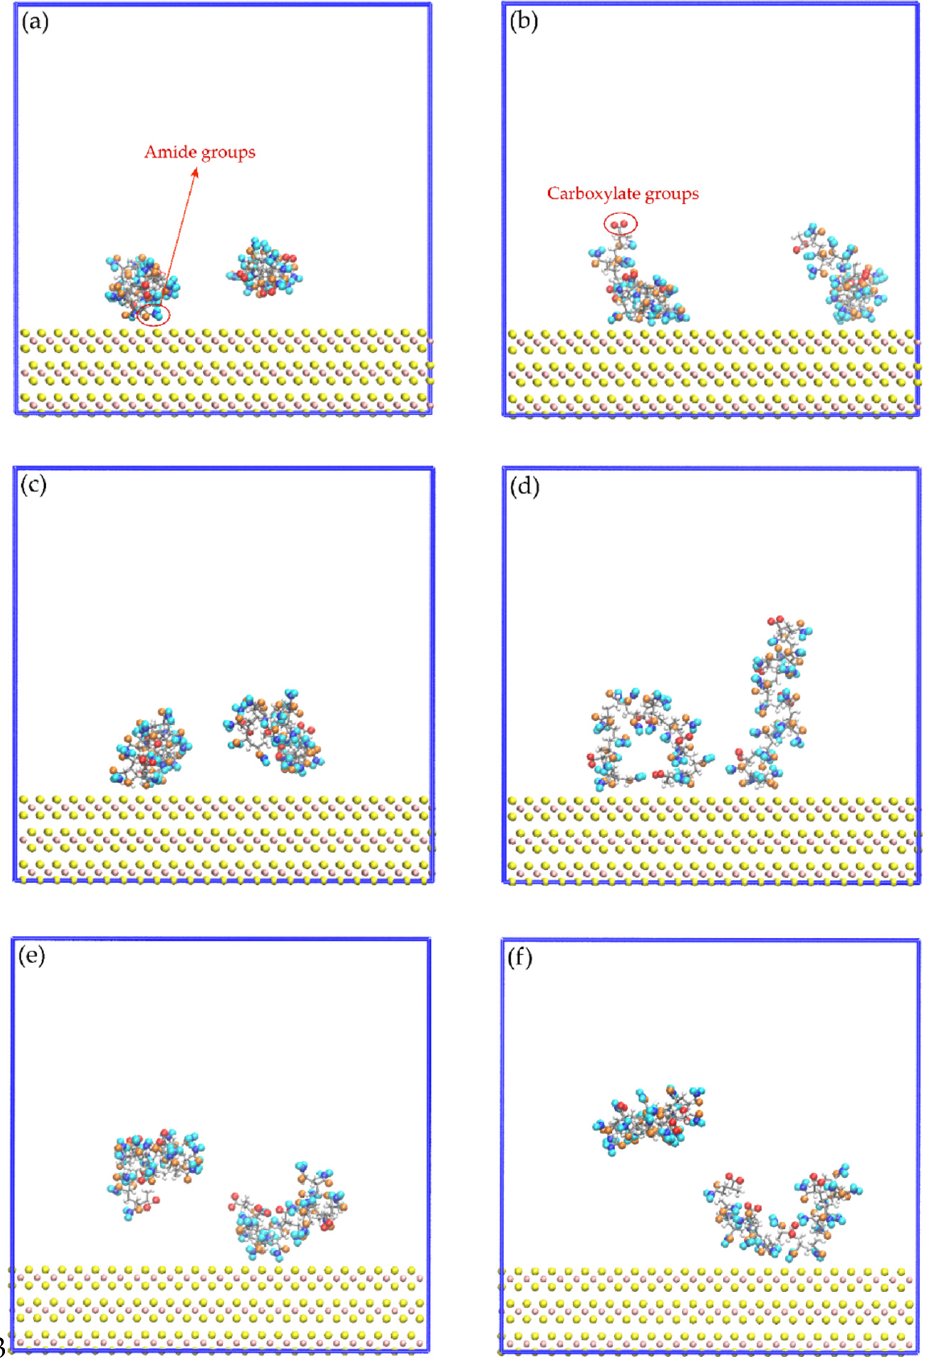
Figure 9. Snapshots of the mineral face/HPAM interfaces: ( a ) No-NaOH, t = 0.1 ns; ( b ) No-NaOH, t = 10.0 ns; ( c ) 1-NaOH, t = 0.1 ns; ( d ) 1-NaOH, t = 10.0 ns; ( e ) 2-NaOH, t = 0.1 ns; ( f ) 2-NaOH, t = 10.0 ns. Na + , Cl − , and OH − ions are not shown to facilitate the visualization of HPAM molecules.